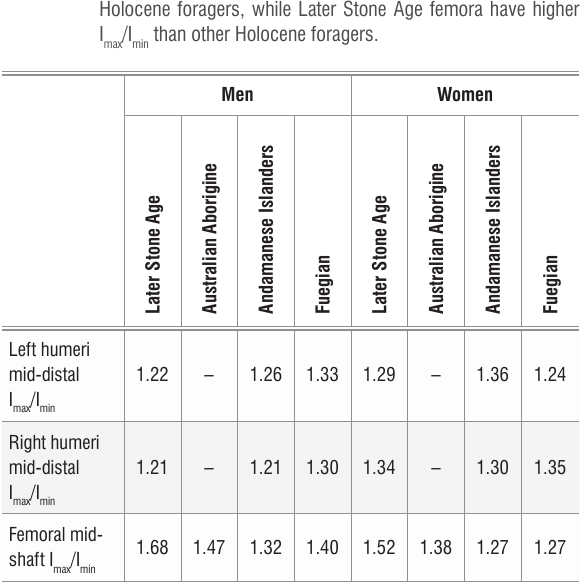
/I . max min /I than other max min